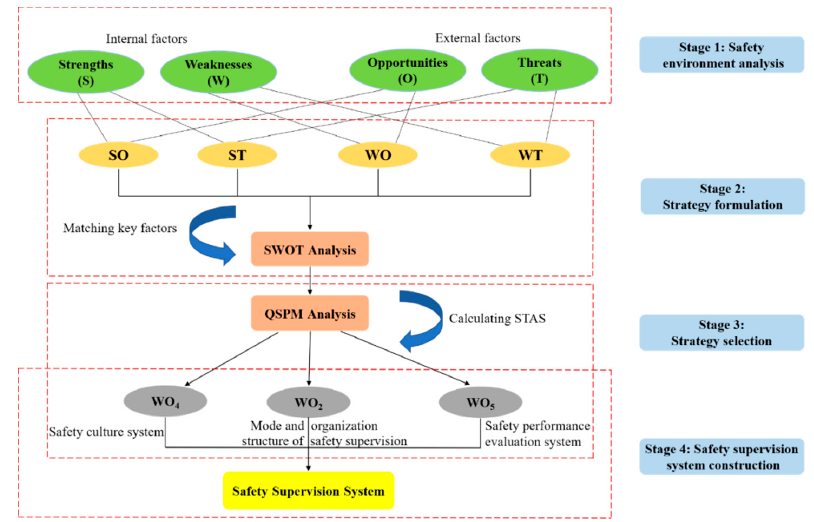
Figure 1. A schematic framework of proposed methods for constructing the safety supervision